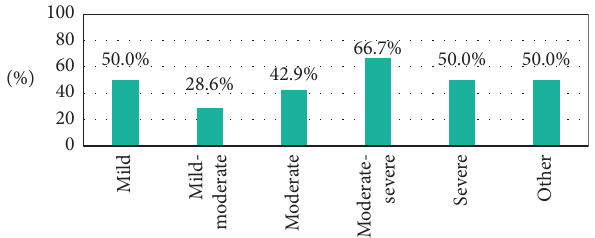
Figure 2: PPV and degree of severity. PPV here is stratified based on degree of severity of melanocytic atypia at diagnosis and pre- sented as a percentage. In our patient population, positive margins were most predictive when a moderate-severe degree of atypia was